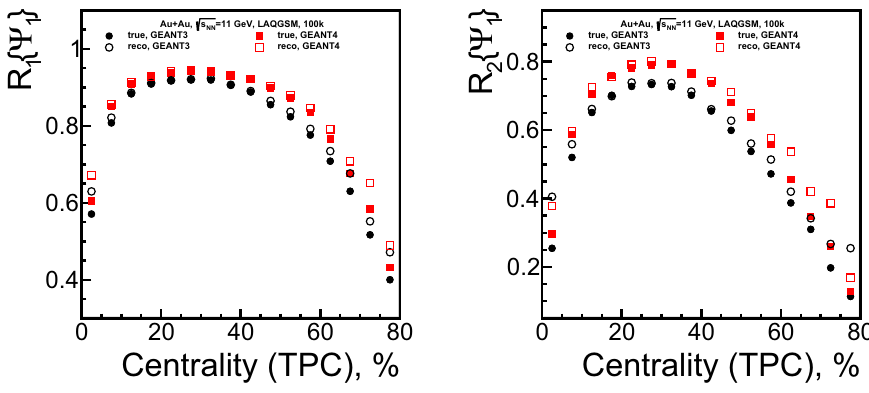
Figure 2. Resolution correction factor as a function of centrality for v 1 (left) and v 2 (right) for the LAQGSM event generator using GEANT3 (GEANT4) framework marked as black (red)